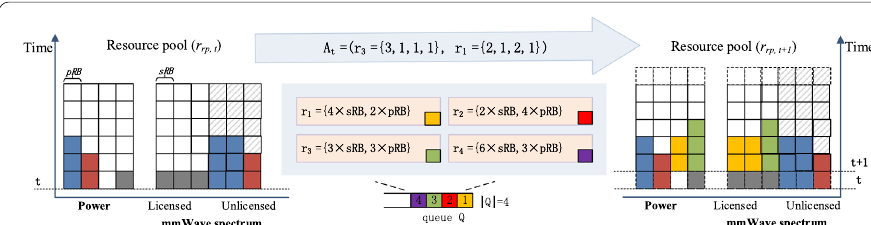
Fig. 4 An example of a state transition. The change of radio resource status from time step t to t 1. Each + small square represents an RB. The two-dimensional coordinates on the left side of figure represent the state of the resource pool at time step t . The two-dimensional coordinates on the right side of figure represent the state of the resource pool at time step t 1. Some RBs have already been occupied by different data (the + colored squares). For example, the blue squares indicate that a URLLC data communication still occupies 3 pRBs and 6 unlicensed sRBs . There are 4 URLLC data resource profiles recorded in queue Q . For example, the first data (yellow) in queue Q require 4 sRBs and 2 pRBs. At time step t 1, one or more data in queue Q will + be allocated radio resources and sent to the mobile user. Since RBs before each time step have been used for data communication and released, the lowermost RBs (dotted squares) of the resource pool are released at time step t 1 and added to the +